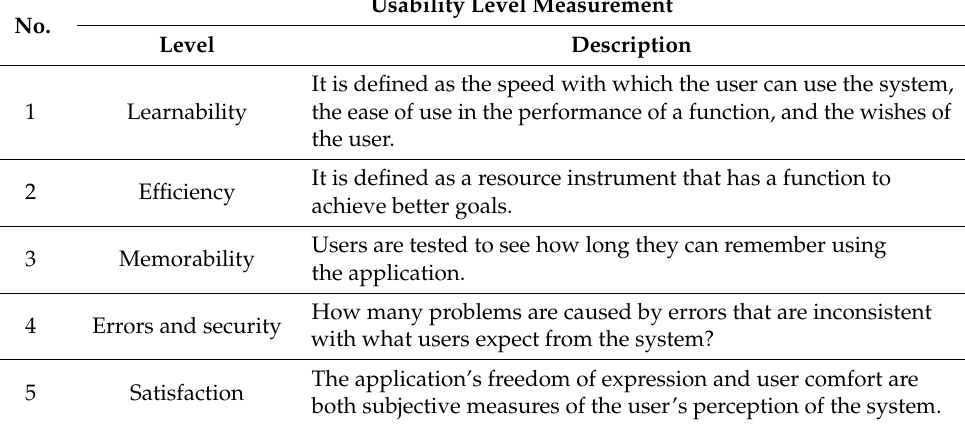
Table 1. Usability Level